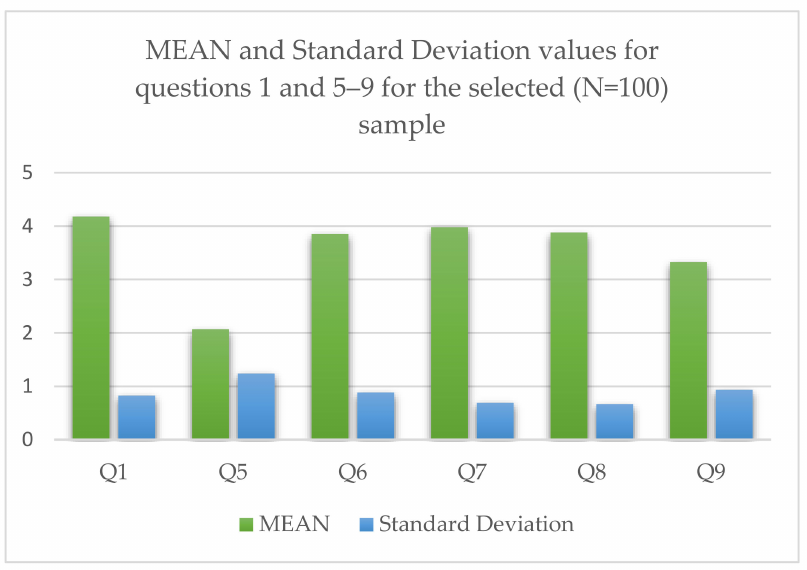
Figure 5. Graph statistics for the respondents’ group (N = 100), concerning some of the important questions (namely, Q1 and Q5–Q9). It is noteworthy that although DJ is not that widespread, the participants showed a high interest in the proposed application. This can be further supported by the fact that the answers’ MEAN values to the questions Q6–Q8 is near 4 (“Agree”), with S.D. values kept below